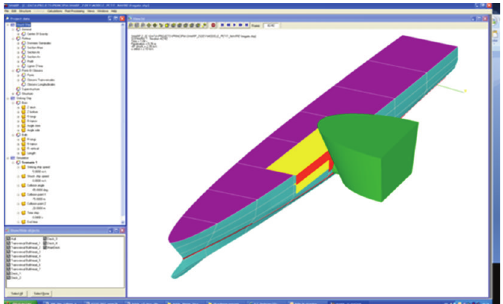
Figure 8: Graphical user’s interface.